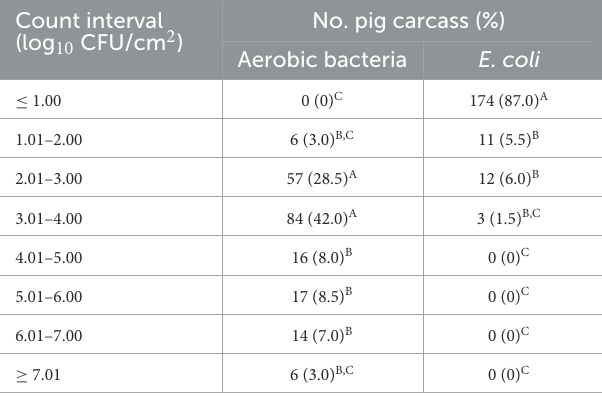
TABLE 2 Distribution of microbial counts in 200 carcasses from 20 pig slaughterhouses. Count interval (log 10 CFU/cm 2 )